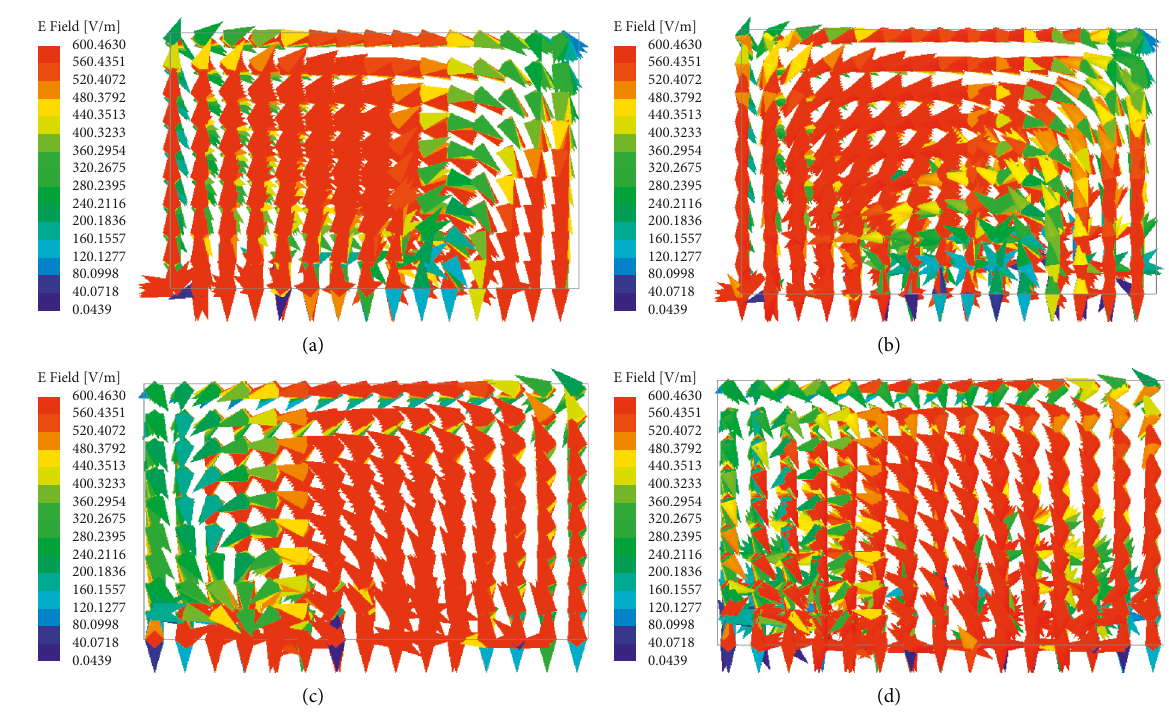
Figure 3: Excited E-field. (a) 4.5 GHz (x-z), (b) 5GHz (x-z), (c) 4.5 GHz (y-z), and (d) 5 GHz